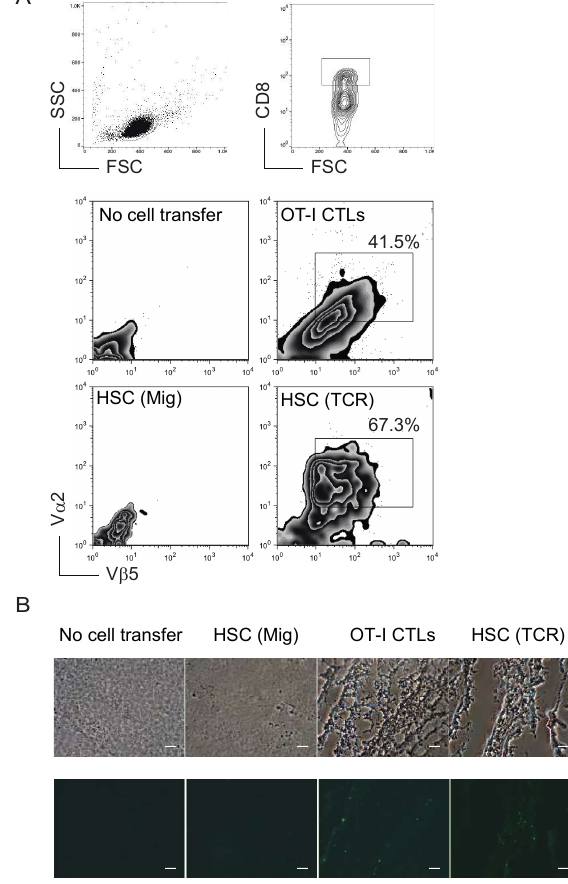
Figure 4. Immunization using genetic modification of HSCs following in vivo priming results in tumor-reactive T cell infiltration. After the development of Ag-specific CD8 + T cells by genetic modification of HSCs following in vivo priming as described in Figure 2, the flank regions of mice were s.c. injected withB16-OVA melanoma cells that express OVA Ag recognizable by the OVA 257–264 -specific CTLs. Mice were subsequently i.v. infected with VV-OVA and were i.p. administered rIL-2 after tumor inoculation twice per day for 3 days. On days 14 and 20 after tumor challenge, tumor tissues were examined for tumor-reactive T cell infiltration. ( A ) Single-cell suspensions from tumor tissues were analyzed for expression of TCRVα2 + and TCRVβ5 + by flow cytometry, after gating on the CD8 + population (upper panels). Data are representative of three independent experiments ( n = 6). ( B ) Immunohistological staining (scale bars: 20 μm). OVA-specific TCRVα2 + CD8 + T cells in green infiltrated into tumor tissues in black. Data shown are representative of three identical experiments.